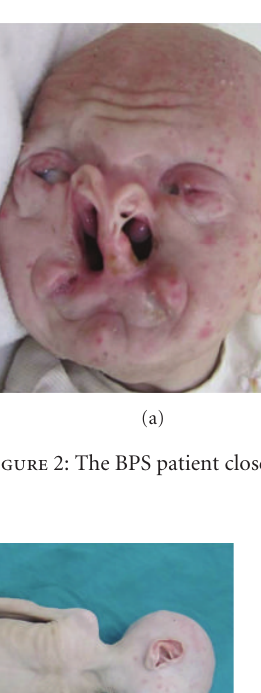
over the chin, while the ears were relatively large, cupp- ed, and low set (Figure